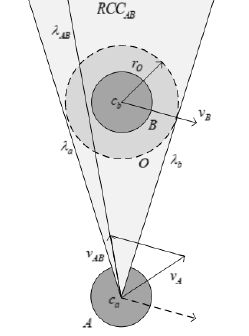
Figure 1. Classical speed barrier